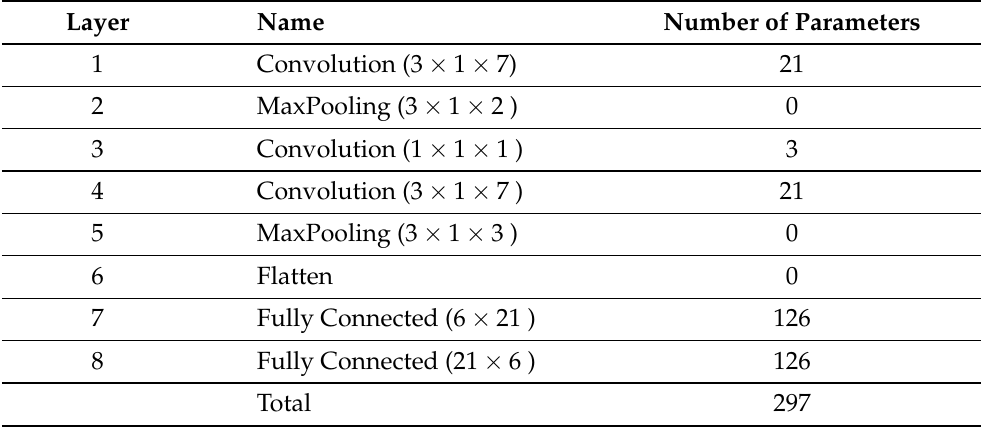
Table 2. Number of parameters in each